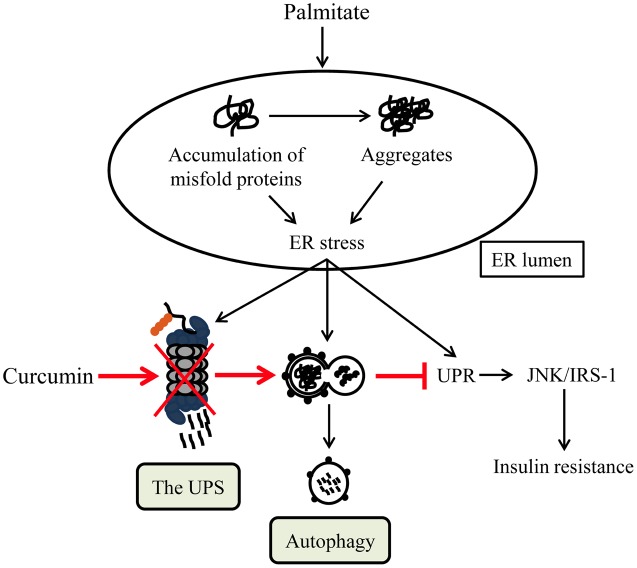
A schematic diagram of curcumin’s impact on palmitate-induced insulin resistance of HUVECs. Palmitate-induced disturbance of ER proteostasis results in ER stress/UPR and the adaptive activation of both the UPS and autophagy (black). The chronic ER stress/UPR leads to insulin resistance. Curcumin administration suppresses the UPS function and greatly activates autophagy, leading to restoration of ER proteostasis, inhibition of ER stress/UPR (red), and subsequent improvement of insulin sensitivity in HUVECs.